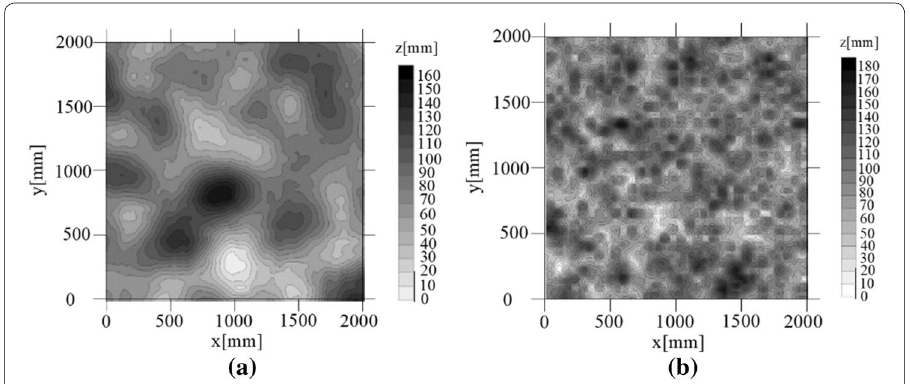
Fig. 4 The synthetic surfaces by random field model